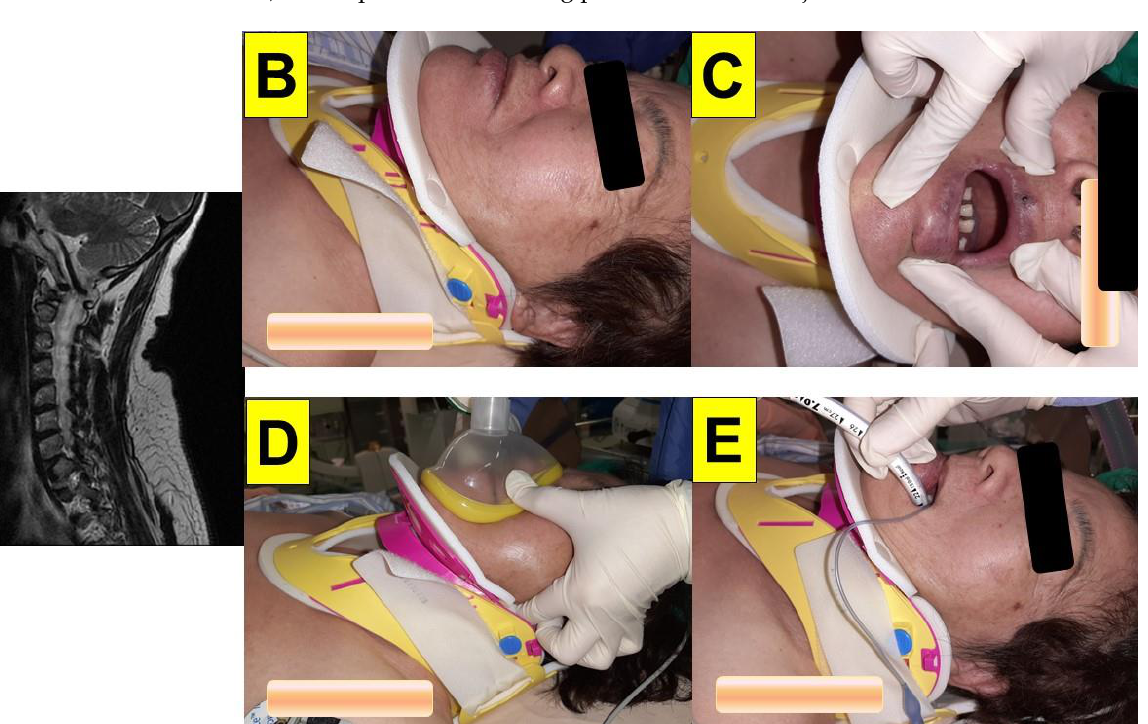
Figure 5. (Case 2) Close-up views during the endotracheal intubation using the video-assisted intu- bating stylet technique. ( A ) Before reaching the laryngeal inlet, ( B ) jaw-thrust maneuver was not applied, and the dropped epiglottis (denoted by the star) was attached to the posterior pharyngeal wall, ( C ) approaching of the intubating stylet to the glottis was facilitated by maneuvering it through the right side of the space (denoted by the white arrow), ( D ) reverting the stylet to the midline under the dropped epiglottis and directing it to the glottis, ( E ) full glottic visualization, ( F ) entry into the